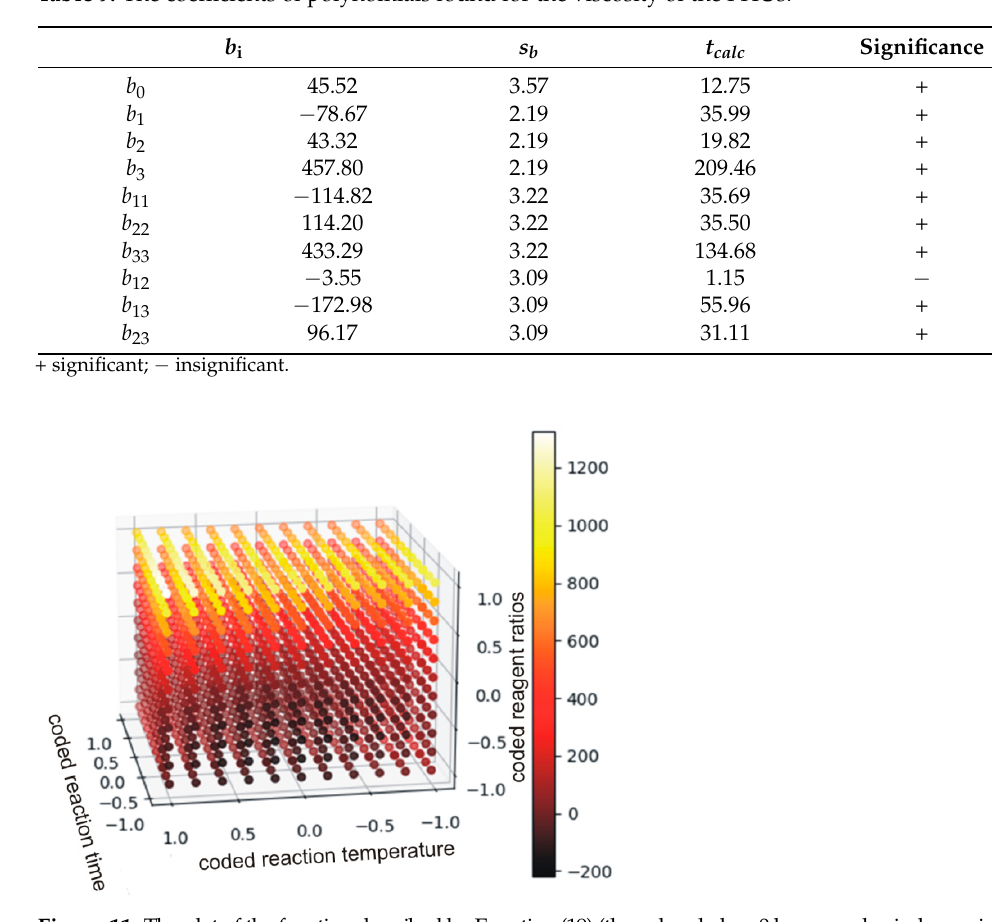
Table 9. The coefficients of polynomials found for the viscosity of the PHUs.